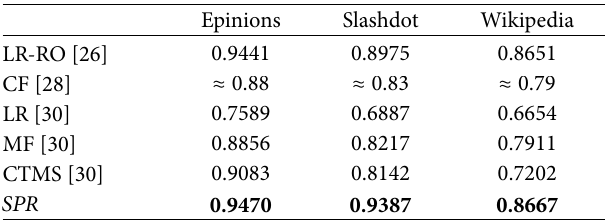
Table 6: The results of 𝑎𝑐𝑐 .